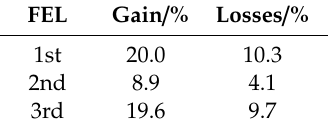
Table 1. The gain and total losses per round-trip of THz wave for three FELs of the NovoFEL facility. FEL Gain / % Losses / % 1st 20.0 10.3 2nd 8.9 4.1 3rd 19.6 9.7